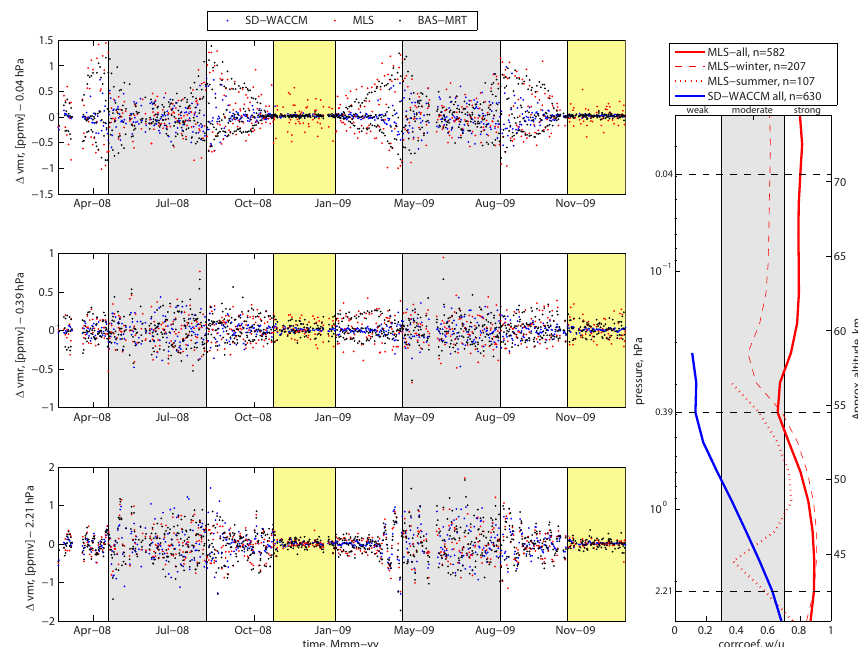
Figure 8. Same as Figs. 6 and 7, but for high-passed filter data with a 20-day cut-o ff (low-pass filter subtracted from the data).